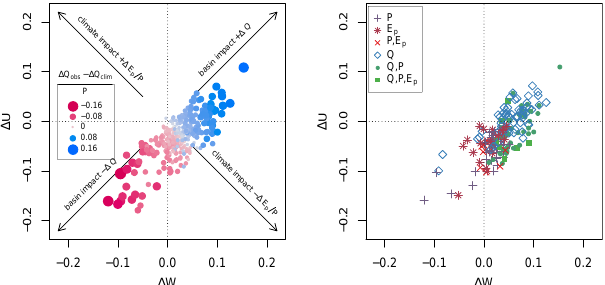
Fig. 7. Observed changes in UW space between the two peri- ods. The arrows represent the conceptual framework of Tomer and Schilling (2009) to separate climate and basin change impacts. Changes falling approximately below the positive diagonal are re- lated to a decrease in aridity. Under a general trend of decreasing aridity, basin changes leading to an increase of the runoff ratio are approximately above the negative diagonal, while basin changes compensating for climatic impacts are below. In the left panel, the size and colour of the dots depict the normalised difference between observed and climatic related streamflow change. The right panel is restricted to basins with significant changes only, using the t-test classification scheme. Note that for displaying reasons we do not show the change for the Snoqualmie River near Carnation, Wash. In this northwestern river, streamflow dropped strongly, while pre-